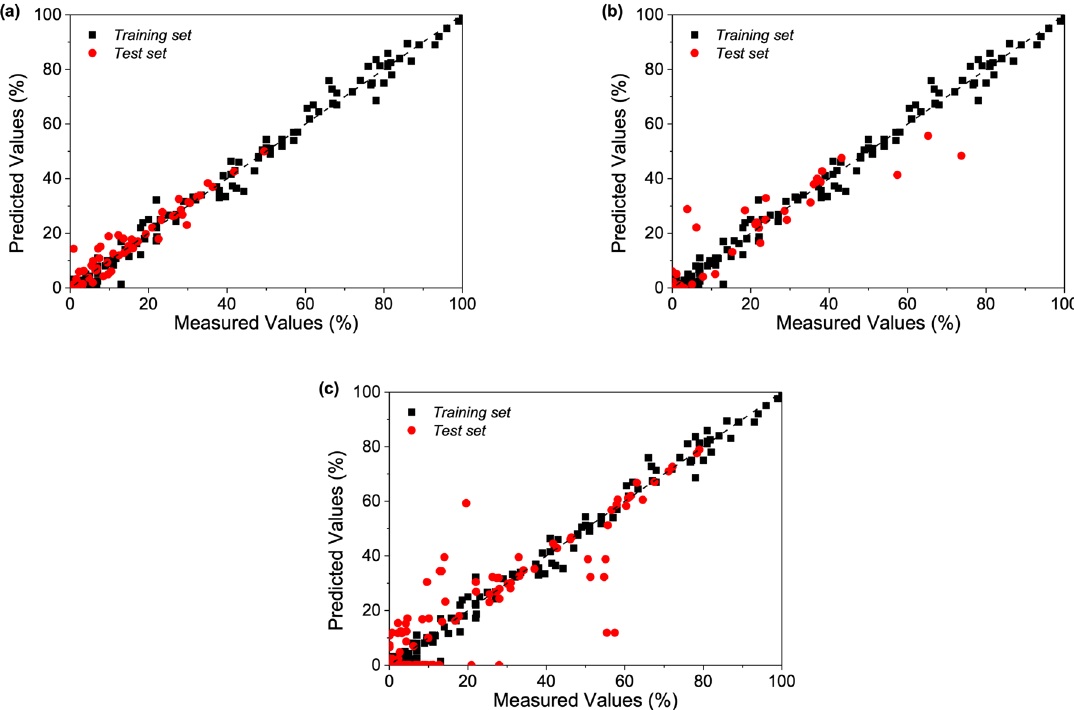
Fig. 2 Ability of statistical mechanics model to predict the fractions of structural species in different glasses. Experimentally measured structural values are plotted against the model predictions using statistical mechanics model (Approach 1) for both the training and test sets. These structural values refer to the relative numbers of bridging and non-bridging oxygens associated with the different network formers (e.g., concentration of Q n units in the case of silicon). All black symbols (training set) are obtained in two-component glasses, while the red symbols (test set) are obtained in a Na 2 O/Li 2 O/Cs 2 O – SiO 2 – B 2 O 3 , b Na 2 O – Al 2 O 3 – SiO 2 , and c Na 2 O/CaO – P 2 O 5 – SiO 2 glasses. All experimentally obtained data from literature are provided and referenced in Supplementary Table 1.